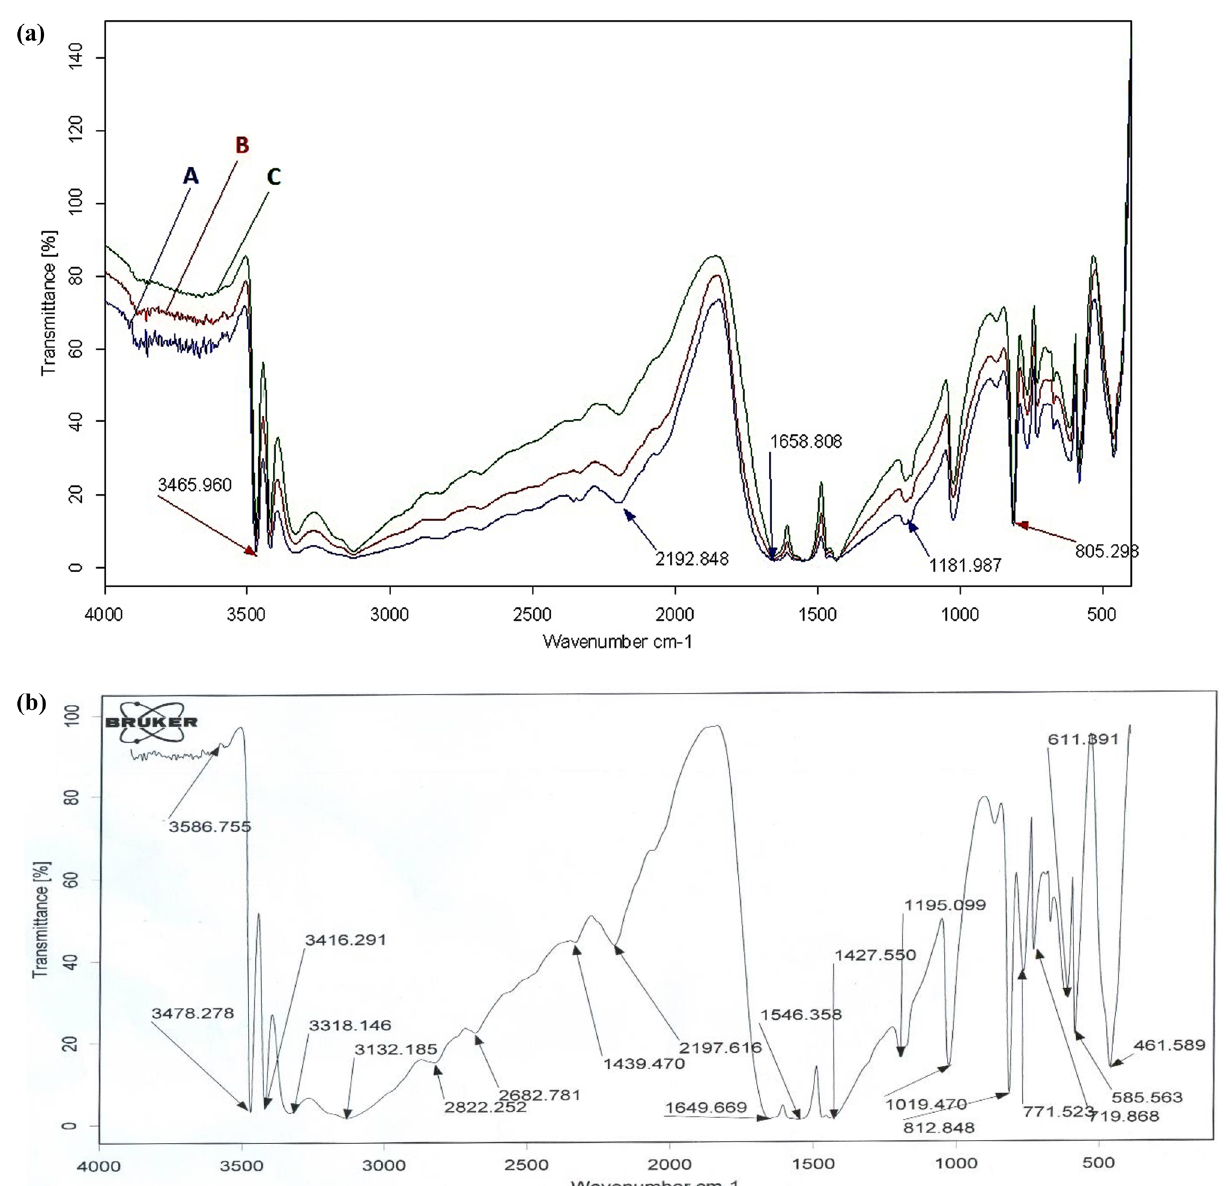
Figure 1. FTIR spectra of melamine ( A ), the Melamine@PrBr ( B ), and the nano-ordered Melamine@TMG ( 1 , C , part a) and the recycled Melamine@TMG catalyst after five consecutive runs in the model reaction (part